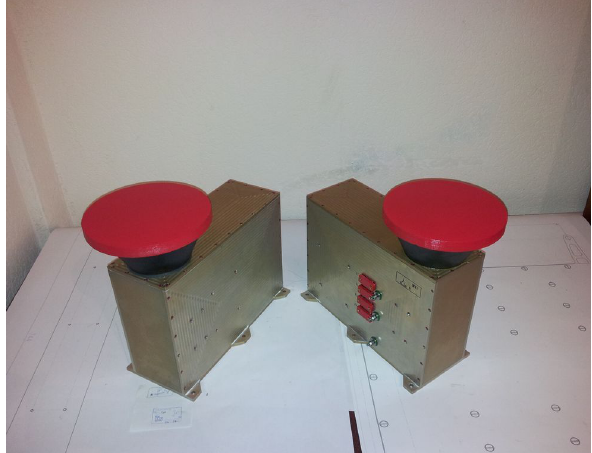
Figure 2. Wide field optical camera units from Lomonosov satellite scientific payload.